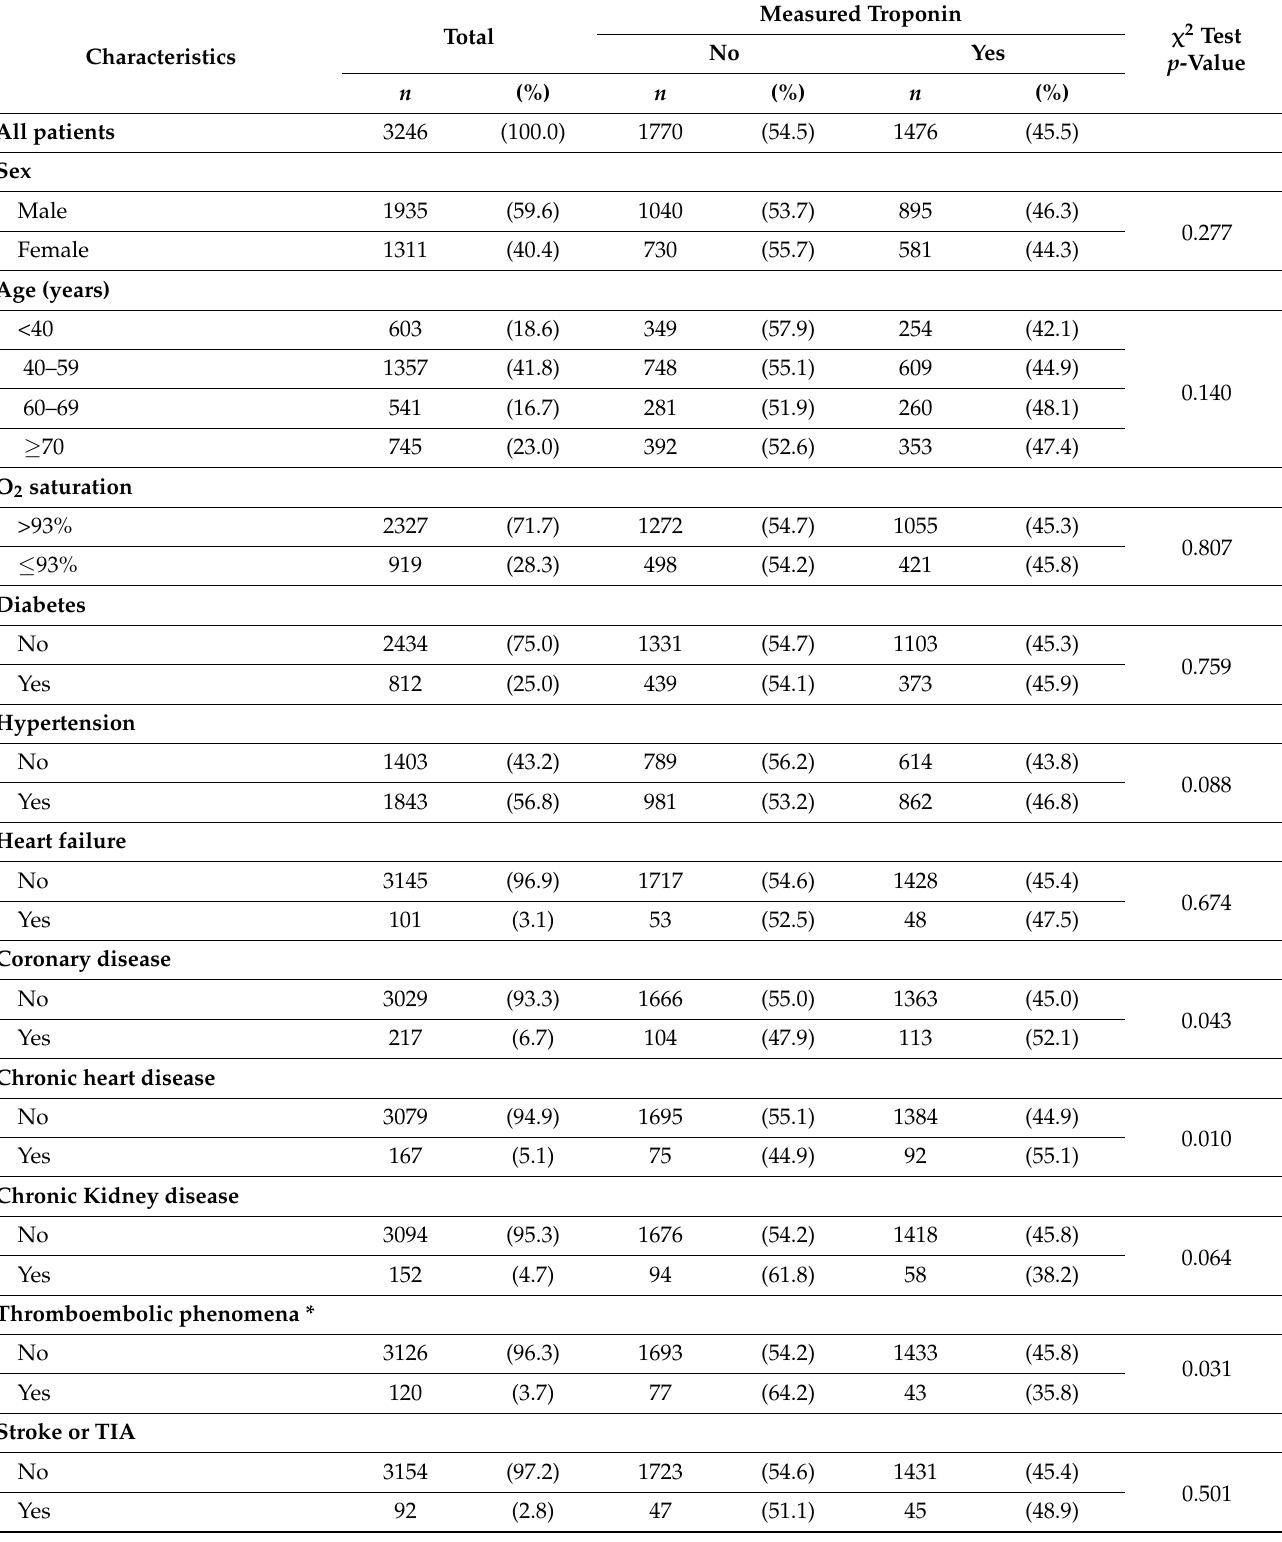
Table 1. Baseline patient characteristics according to troponin